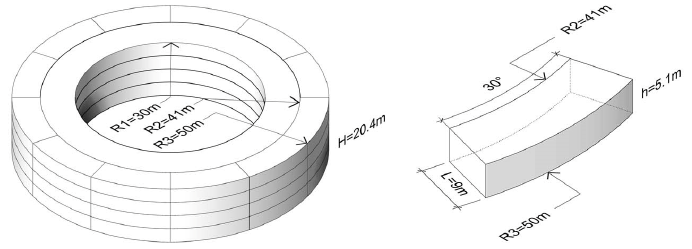
Figure 4. Dimensions of library and reading room units (self-developed).